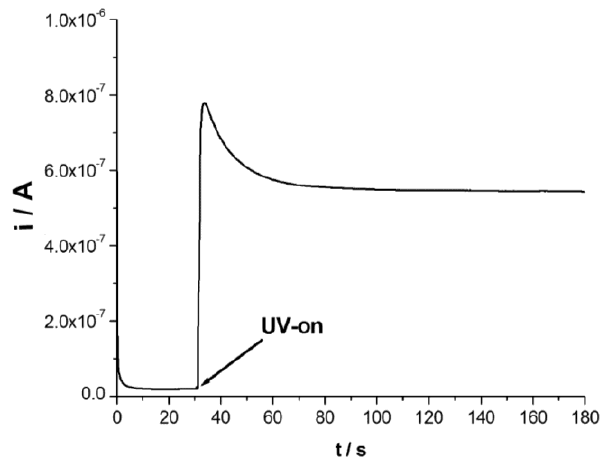
Figure 4. Amperometric i-t curve recorded at the TiO 2 NWA applying a potential step at + 0.4 V vs Ag/AgCl in 0.1 M phosphate buffer, pH 7.0, 10 μM hydrazine. UV irradiation is